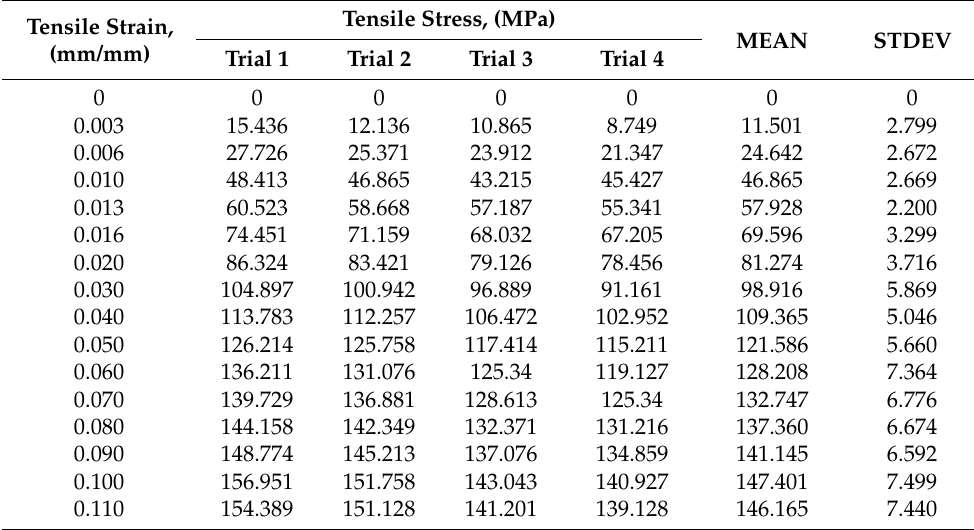
Table A4. Experimental data of stress–strain curve of FPCB for reflow inn Figure